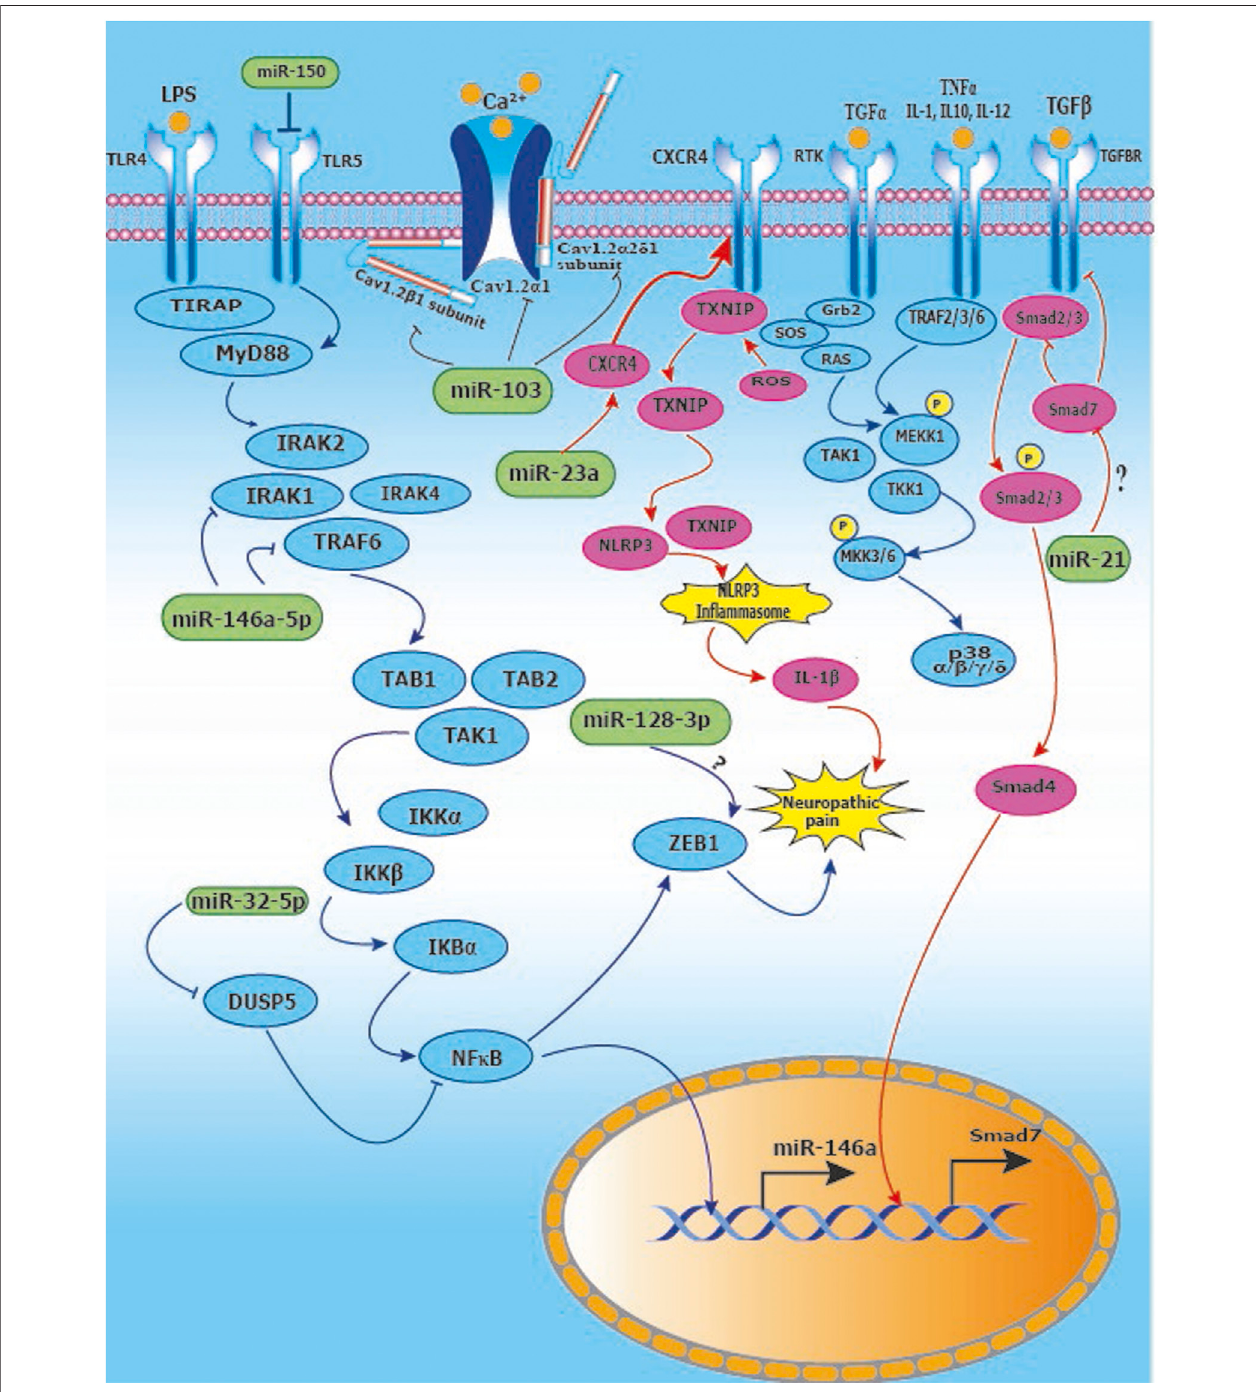
FIGURE7| SignalingpathwaysmodulatedbymiRNAsinneuropathicpain: (A) ActivationofTLR4anddownstreamIRAK/TRAF6signalingleadstoupregulationof NF ĸ B and ZEB1 leading to neuropathic pain. miR-146a-5p inhibits IRAK1 and TRAF6 which are upstream of NF ĸ B. Further, miR-32-5p inhibits DUSP5 resulting in suppression of NFkB signaling. miR-128-3p interacts with ZEB1, however, the nature of the interaction remains to be explored; (B) Inducing miR-103 suppresses the expression of subunits Cav1.2- α 1, Cav1.2- α 2 δ 1 and Cav1.2- β 1 of Cav1.2-comprising L-type calcium channel thus relieving neuropathic pain; (C) Suppression of miR-23aresultsinupregulationofCXCR4whichmediatesneuropathicpainviatheTXNIP/NLRP3in fl ammasomeaxis; (D) Thep38MAPKinasepathway isimplicatedin neuropathic pain and miR-26a-5p downregulates MKK3/6 upstream of p38, whereas miR-21 inhibits Spry1 leading to RAS inhibition in the MAP Kinase signaling